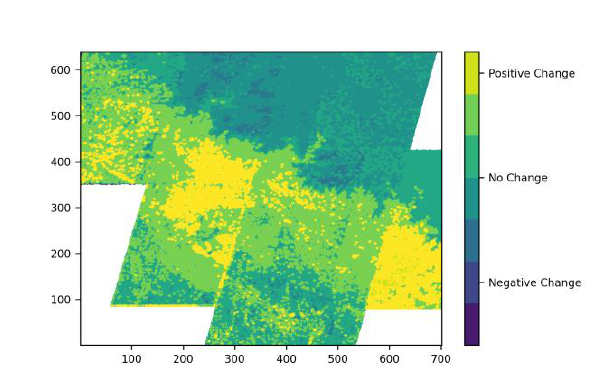
Figure 17. 2015-2005 Change Detection